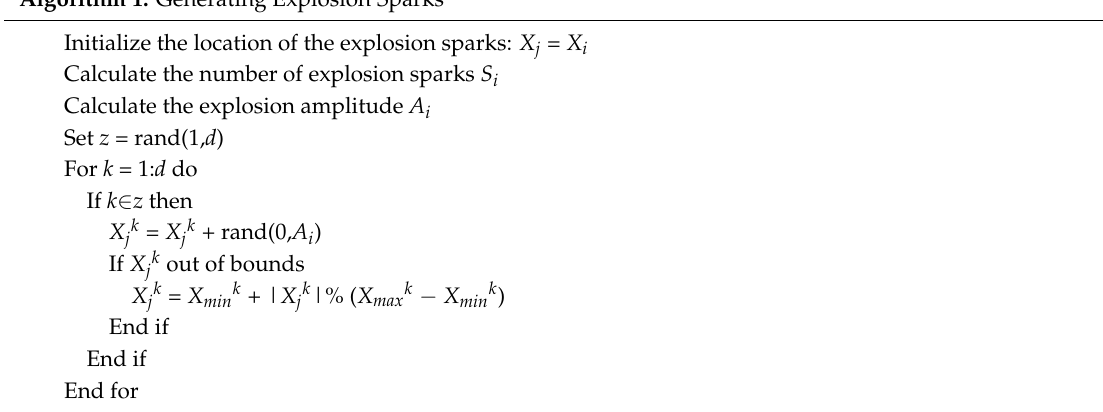
Algorithm 1: Generating Explosion Sparks